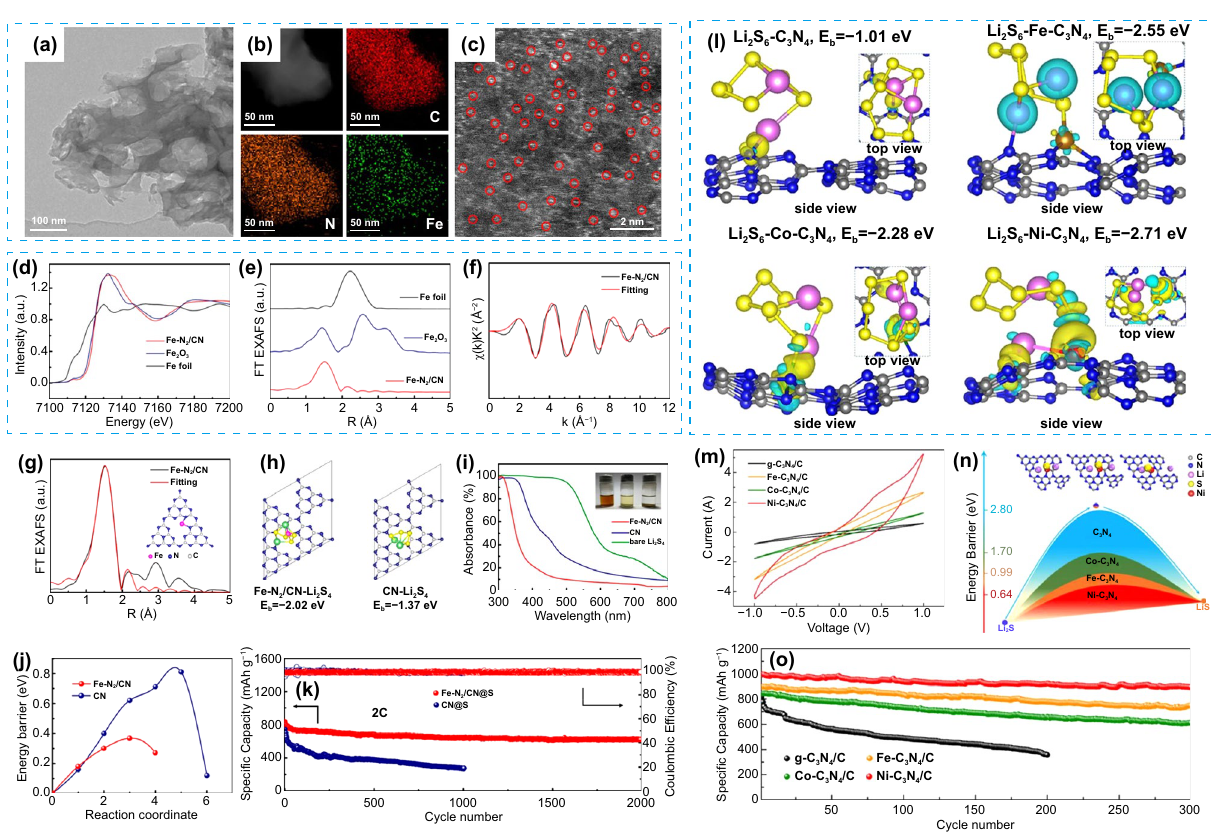
Fig. 6 a TEM image and b corresponding EDS mappings and c HAADF‑STEM image of Fe‑N 2 /CN. d Fe K‑edge XANES spectra and e Fou‑ rier transformation of Fe K‑edge EXAFS spectra of Fe‑N 2 /CN, Fe foil, and Fe 2 O 3 . f Fe k‑space EXAFS curve and corresponding fitting curve, and g Fe r‑space EXAFS curve and corresponding fitting curve of Fe‑N 2 /CN. h Optimized structures and binding energies of Li 2 S 4 adsorbed on Fe‑N 2 /CN and CN surfaces. i UV–vis spectra of Li 2 S 4 solution with CN and Fe‑N 2 /CN. j Decomposition energy barriers of Li 2 S on Fe‑N 2 /CN and CN surfaces. k Cycling performance of cells with CN@S and Fe‑N 2 /CN@S cathodes at 2C [85]. Copyright 2020, American Chemical Soci‑ ety. l Differential charge densities of Li 2 S 6 adsorbed on C 3 N 4 , Fe‑C 3 N 4 , Co‑C 3 N 4 and Ni‑C 3 N 4 . m CV curves of symmetric cells with g‑C 3 N 4 /C, Fe‑C 3 N 4 /C, Co‑C 3 N 4 /C and Ni‑C 3 N 4 /C modified separators. n Decomposition barriers of Li 2 S on C 3 N 4 , Fe‑C 3 N 4 , Co‑C 3 N 4 and Ni‑C 3 N 4 . o Cycling performance of cells with g‑C